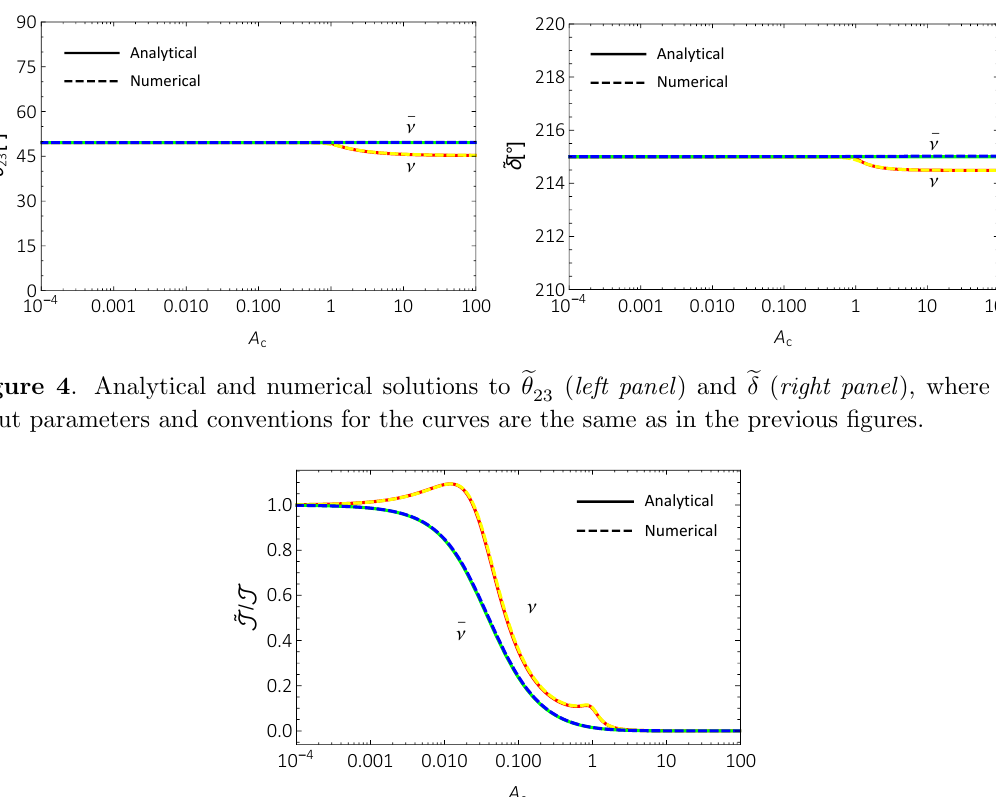
Figure 5 . Analytical and numerical solutions to e J = J in the case of normal neutrino mass ordering, where the input parameters and conventions for the curves are the same as in the previous (cid:12)gures. It is easy to solve eq. (3.19) with the initial condition e (cid:18)